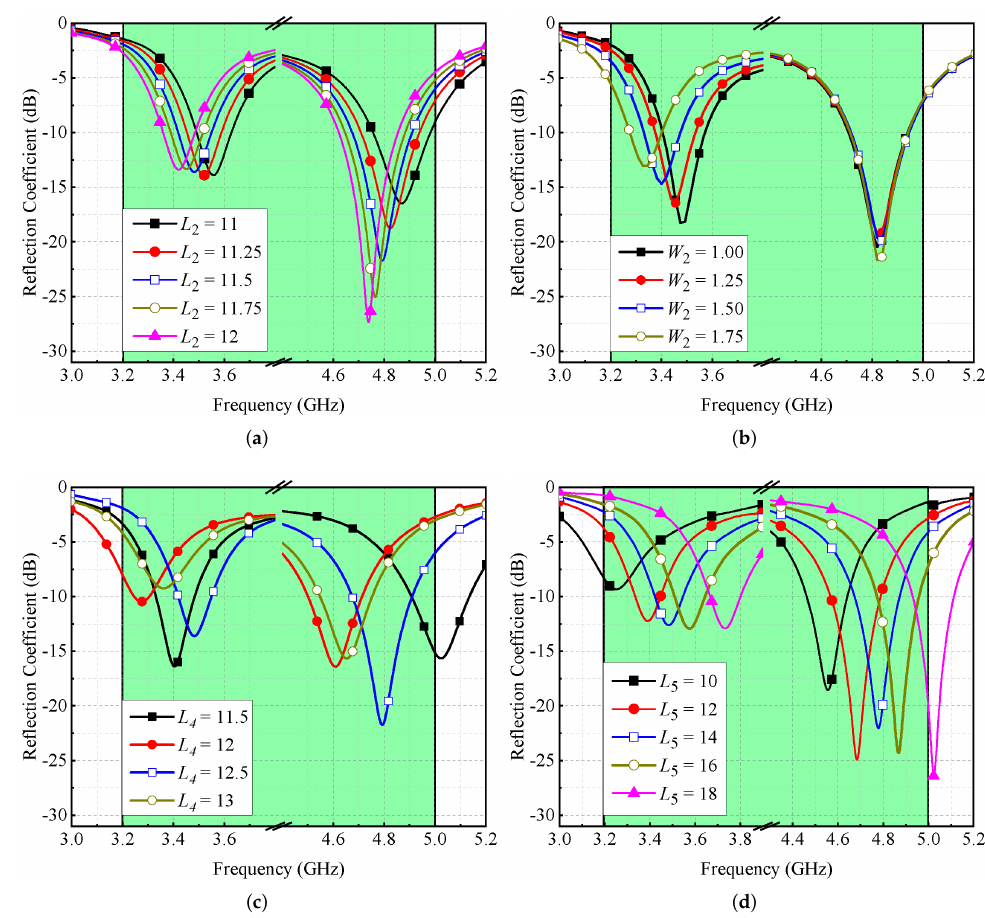
Figure 5. Effect of ( a ) L 2 , ( b ) W 2 , ( c ) L 4 , and ( d ) L 5 on antenna’s reflection coefficient. Figure 5. Effect of (a) L 2 (b) W 2 (c) L 4 , and (d) L 5 on antenna’s reflection coefficient. The MIMO system is modeled by incorporating a single antenna element into two The MIMO system is modeled by incorporating a single antenna element into two 117 linear sub-arrays placed on either side of the PCB in the vertical direction, as shown in linear sub-arrays placed on either side of the PCB in the vertical direction, as shown in 118 Figure 6a. Each sub-array consists of four radiating elements. The corner and the center Figure 6a. Each sub-array consists of four-radiating elements. The corner and the center 119 elements are arranged in different ways to improve isolation without using any decoupling elements are arranged in different ways to improve isolation without using any decoupling 120 Figure 5. Effect of (a) L 2 (b) W 2 (c) L 4 , and (d) L 5 on antenna’s reflection coefficient. structure or signal processing techniques (see Figure 6a). The ground plane consists of structure or signal processing techniques (see Figure 6a). The ground plane consists of eight 121 eight rectangular slots, and the antenna elements are fed using a 50 Ω coaxial connector, rectangular slots, and the antenna elements are fed using a 50 Ω coaxial connector, as shown 122 as shown in Figure 6b. The total dimensions of the board are 150 75 mm 2 , which is The MIMO system is modeled by incorporating a single antenna element into two 117 × in Figure 6b. The total dimensions of the board are 150 75 mm 2 , which is well-aligned with 123 well-aligned with modern mobile phone dimensions. It should be noted that the × linear sub-arrays placed on either side of the PCB in the vertical direction, as shown in 118 modern mobile phone dimensions. It should be noted that the overall area occupied by one 124 Figure 6a. Each sub-array consists of four-radiating elements. The corner and the center 119 elements are arranged in different ways to improve isolation without using any decoupling 120 structure or signal processing techniques (see Figure 6a). The ground plane consists of eight 121 rectangular slots, and the antenna elements are fed using a 50 Ω coaxial connector, as shown 122 in Figure 6b. The total dimensions of the board are 150 × 75 mm 2 , which is well-aligned with 123 modern mobile phone dimensions. It should be noted that the overall area occupied by one 124